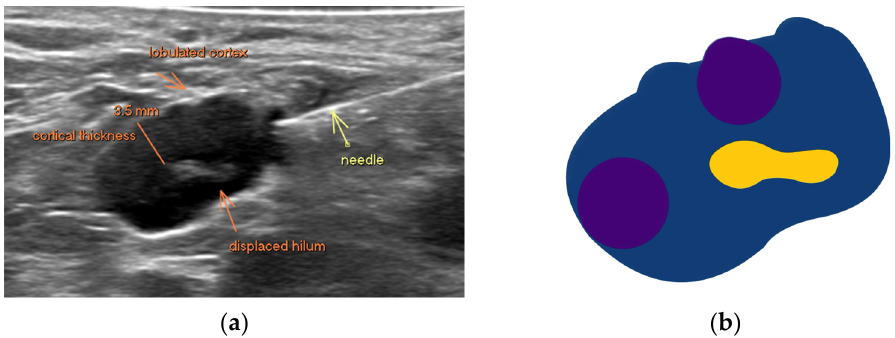
Figure 1. ( a ) Ultrasound demonstrates the morphology of a suspicious axillary lymph node, confirmed malignant post-biopsy. There is diffuse cortical thickening of 3.5 mm, with a lobulated contour and displaced hilum. The needle abuts the cortex in this image. ( b ) Schematic representation of node with deformed displaced hilum (yellow), multilobulated cortical outline (blue) and subcapsular metastatic deposits (purple).